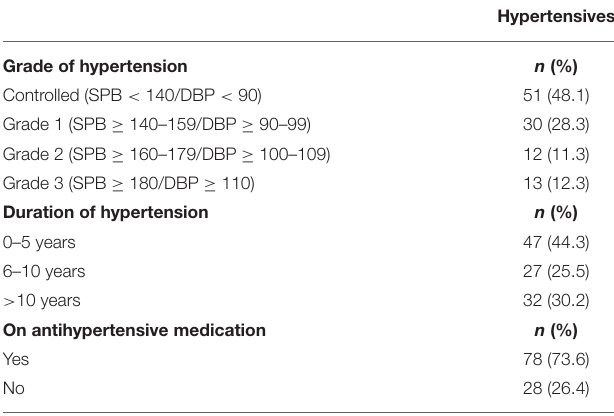
TABLE 2 | Hypertension characteristics among study